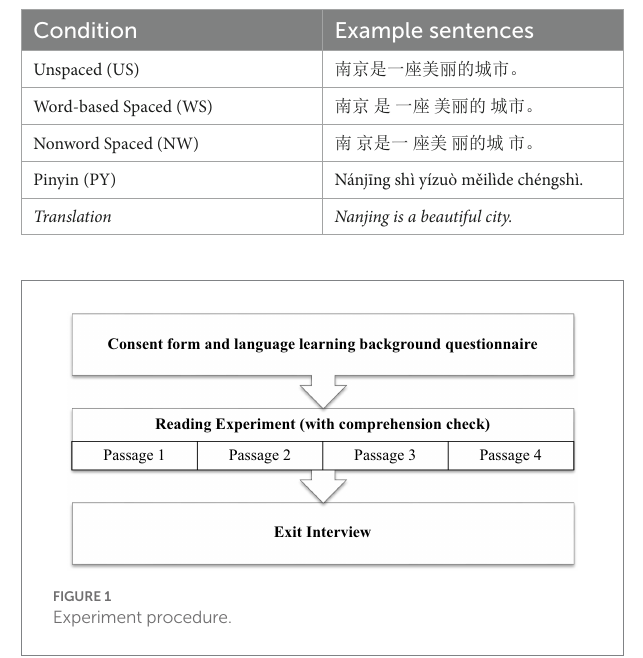
TABLE 2 Example sentence for each condition.